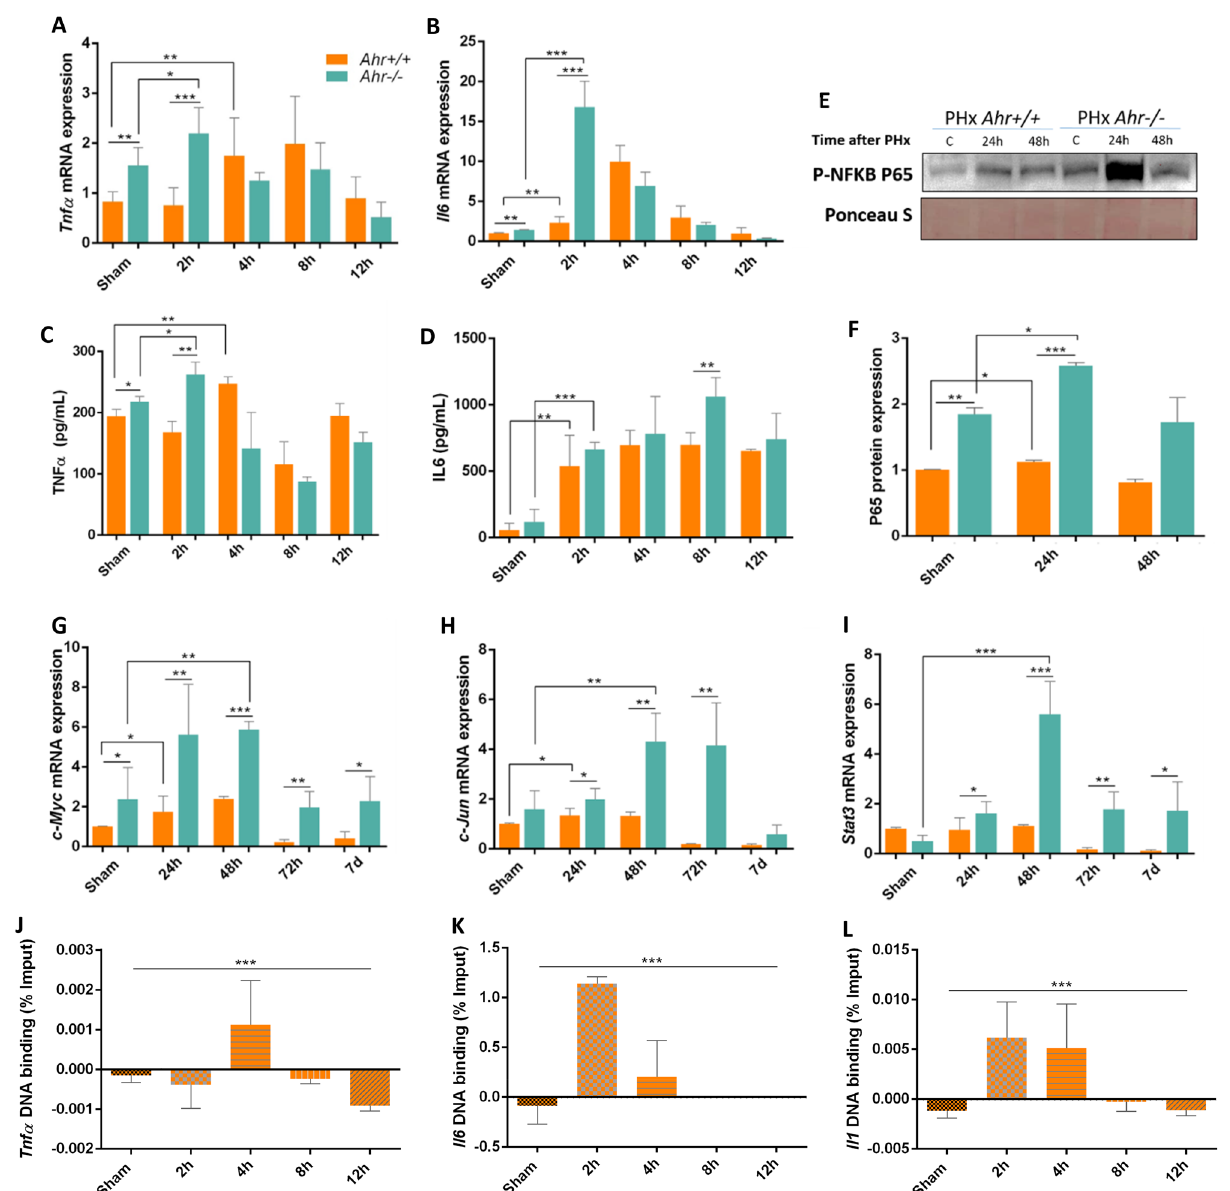
Figure 4. Ahr deficiency improves the cytokine network during the "priming phase” of regeneration. mRNA levels for TNFα ( A ) and IL6 ( B ) were determined by RT-qPCR in Ahr + / + and Ahr −/− liver at the indicated times after 2/3 PHx. Cytokine levels for TNFα ( C ) and IL6 ( D ) were measured in serum samples from the same mice and under the same experimental conditions. ( E ) Protein expression of p-p65-NFκβ (Ser536) was analyzed in liver extracts of mice at the indicated time points after PHx by immunoblotting and quantified by densitometry ( F ). Ponceau staining was used to normalize protein levels. ( G – I ) mRNA expression of c-Myc ( G ), c-Jun ( H ) and Stat3 ( I ) was quantified using RT-qPCR. Gapdh was used to normalize target gene expression (ΔCt) and 2 −ΔΔCt to calculate changes in mRNA levels with respect to sham-surgery control mice. ( J – L ) Chromatin immunoprecipitation (ChIP) for Ahr binding to XRE binding sites located in the promoter of Tnfα ( J ), Il6 ( K ) and Il1 ( L ) was performed. qPCR was used to quantify changes in DNA binding and the results were normalized to the corresponding input samples. *p < 0.05, **p < 0.01, ***p < 0.001. Data are shown as mean ± SD. The experiments were performed using three mice per time point and three technical replicates were done. Oligonucleotides for gene expression analyses and for ChIP are indicated in Supplementary Tables 1 and 2, respectively. Antibodies used are indicated in Supplementary Table